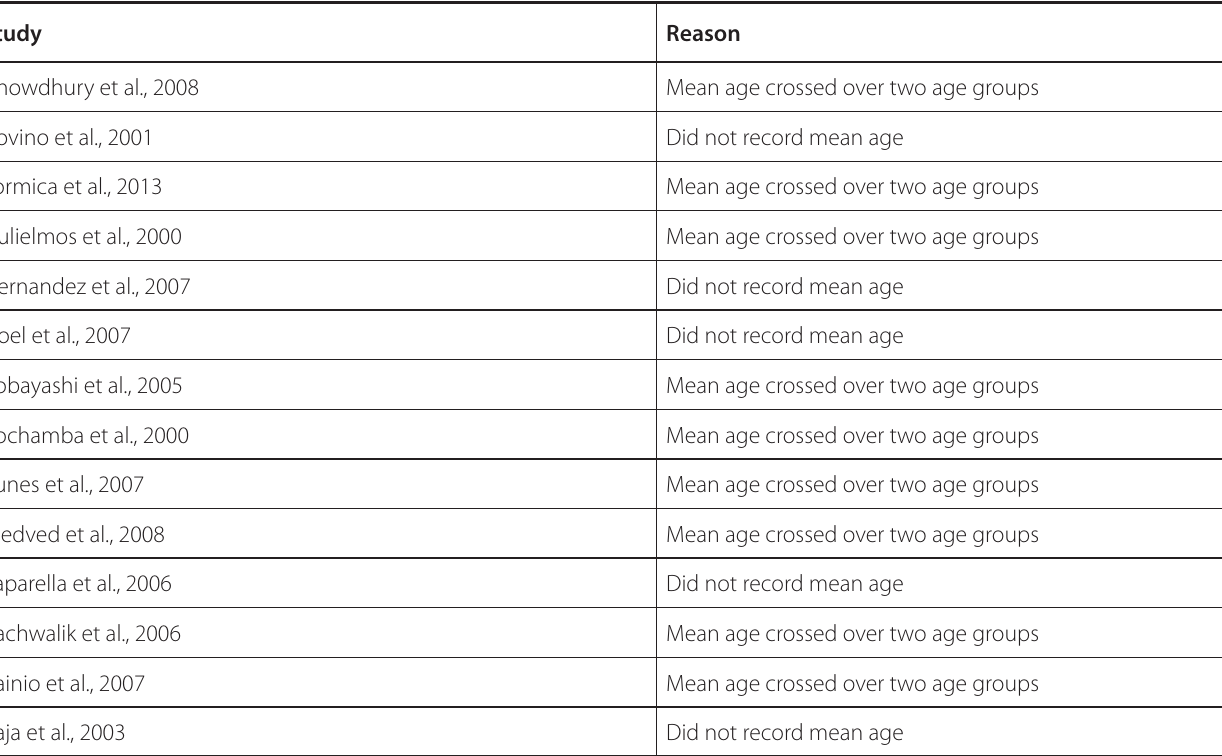
Supplementary Table 1 . Excluded studies and reasons for exclusion.